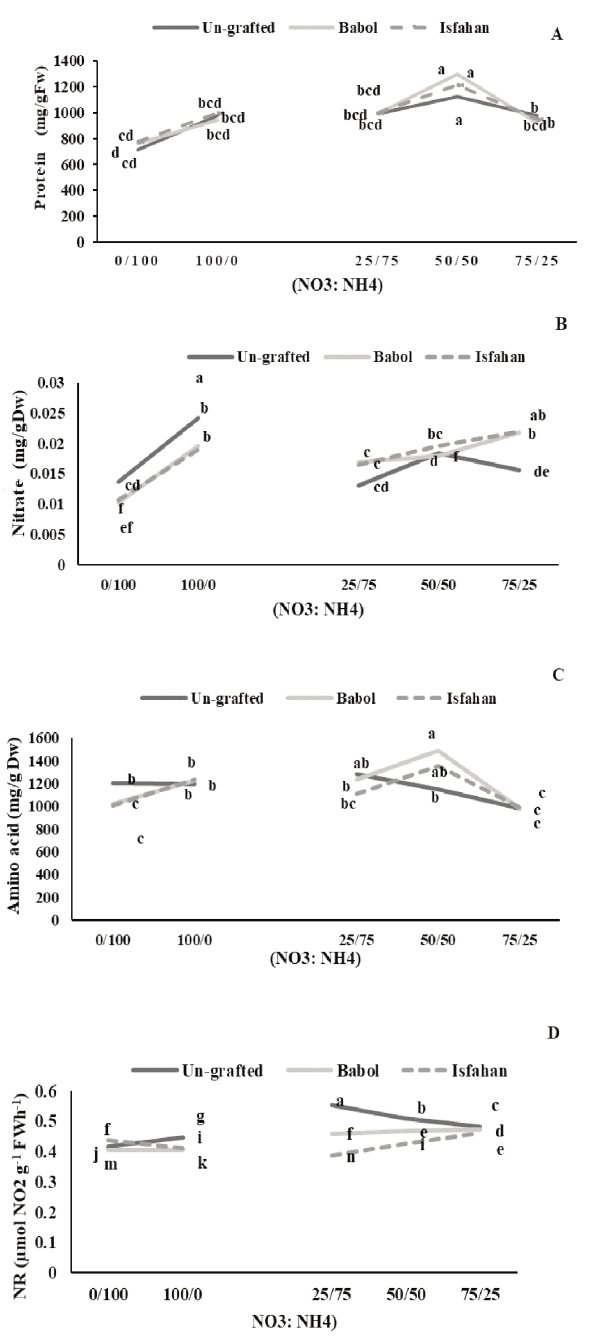
Fig. 6 ­ The interaction effects of different rootstocks and NO :NH ratio on A) protein, B) nitrate and C) amino acid 3 4 D) nitrate reductase (NR)